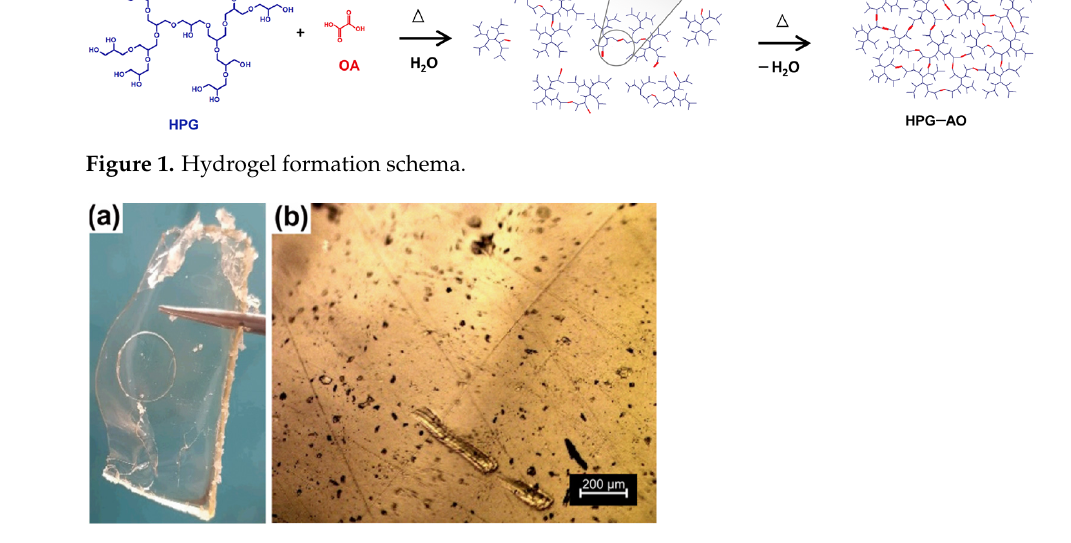
Figure 2. Oxalic acid crosslinked hyperbranched polyglycerol hydrogel HPG-OA1: ( a ) photography and ( b ) optical microscopy image obtained in transmission mode (100×).